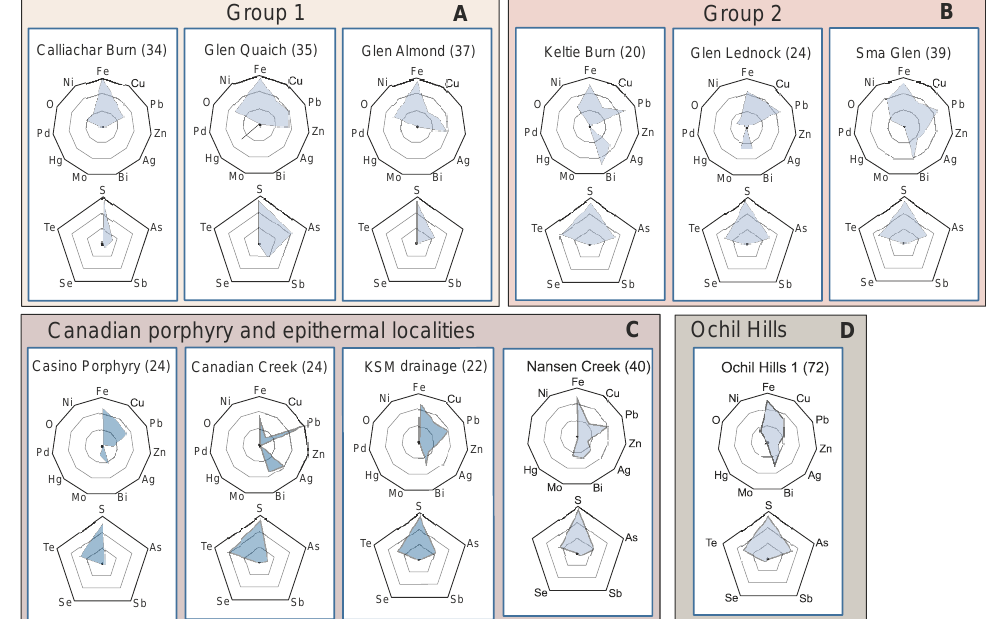
Figure 8. Radar plots showing the elemental components of the various inclusion suites, according to group and locality. Data origins: as per Figure 7: ( A ) Sample localities of Group, ( B ) Sample localities of Group 2, ( C ) Inclusion signatures in gold from Canadian porphyry and epithermal localities, [10], ( D ) Inclusion signature of gold from Ochil Hills, Scotland [32]